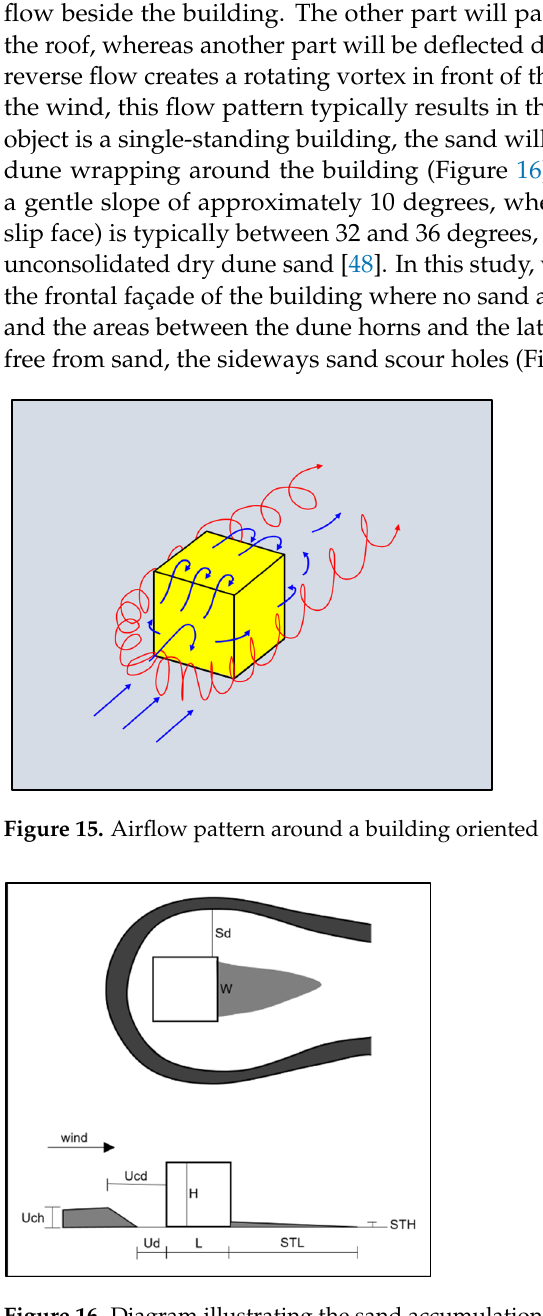
Figure 16. Diagram illustrating the sand accumulation parameters for a single ‐ standing